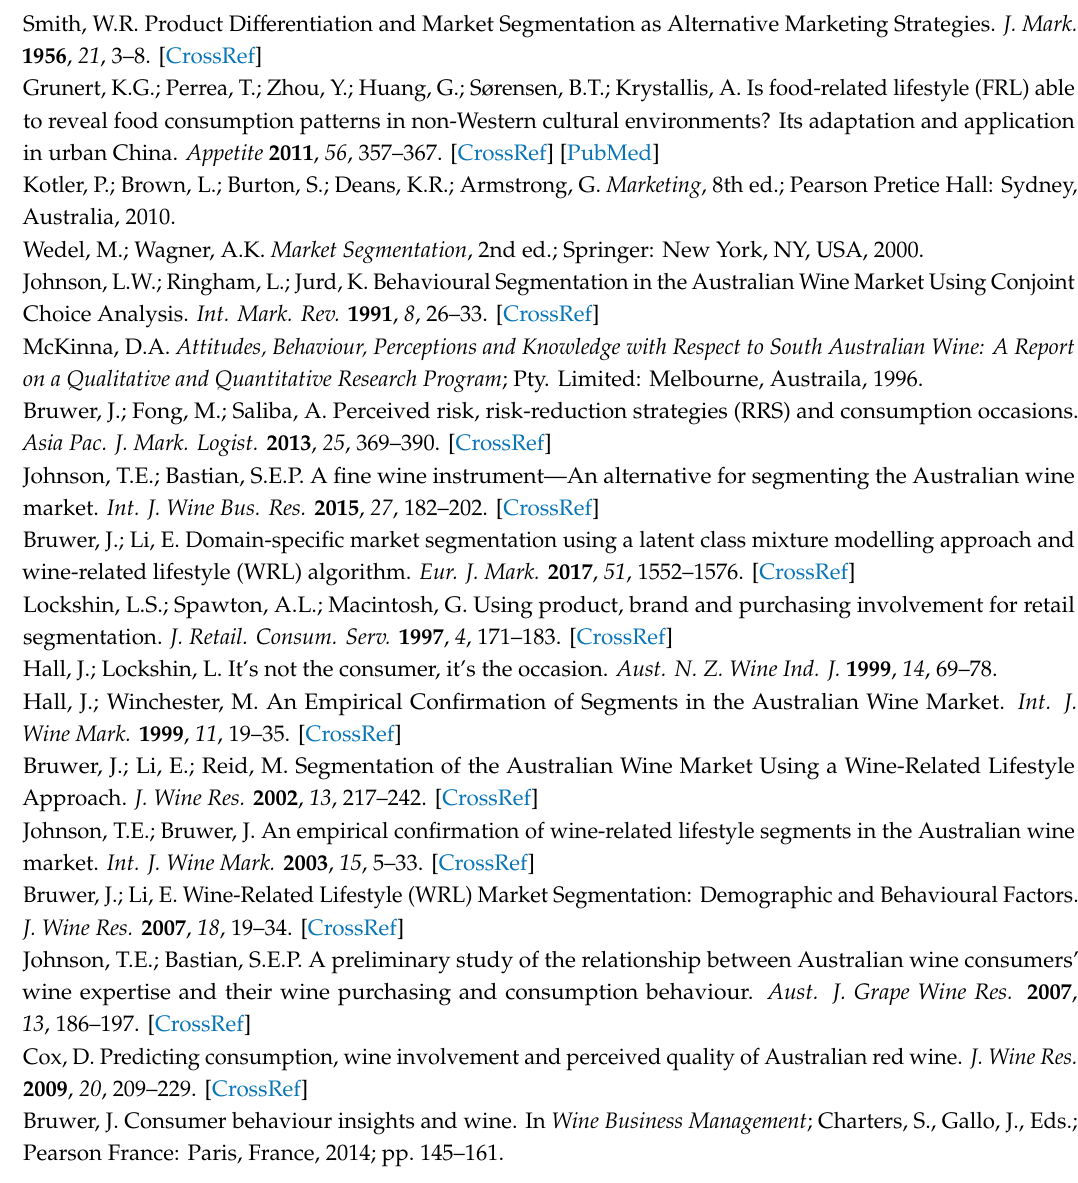
Bolded values indicate significant e ff ects at p <